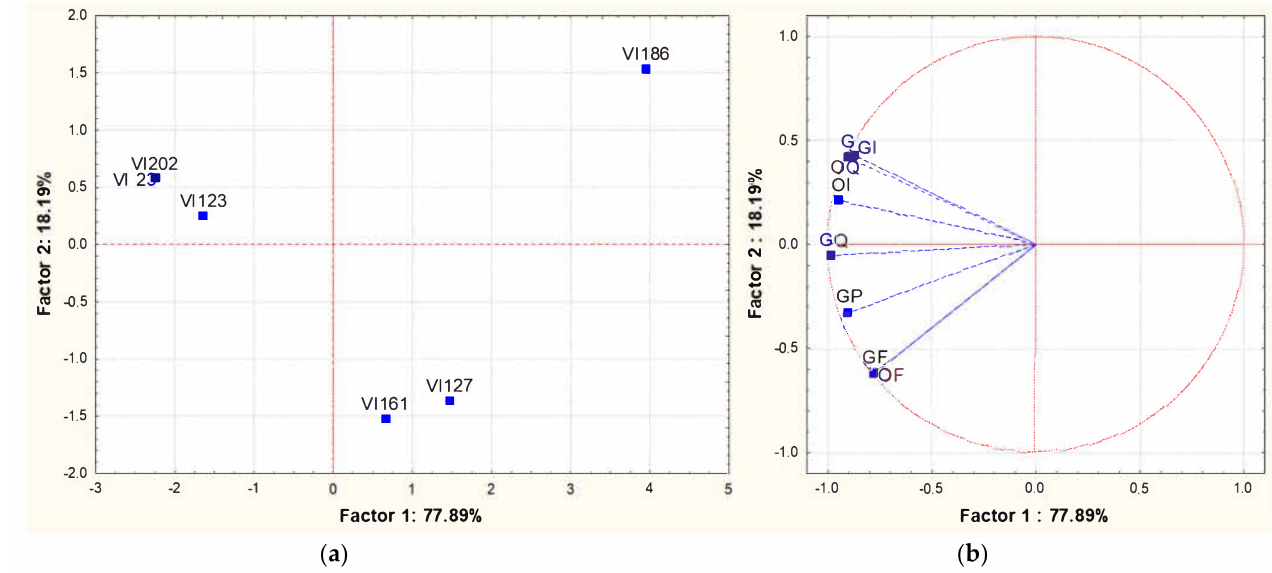
Figure 4. Principal Component Analysis carried out on sensory analysis of the wines obtained with different S. cerevisiae indigenous strains (VI 23-VI 123-VI 127-VI 161-VI 186 and VI 202). The experimental approach is the one proposed by the OIV [36]. ( a ): similarity map determined by Principal Component (Factor) 1 and 2; ( b ): projection of the variables on the factor plane. Variables: OF: olfactory frankness; OI: olfactory intensity; OQ: olfactory quality; GF: gustatory frankness;